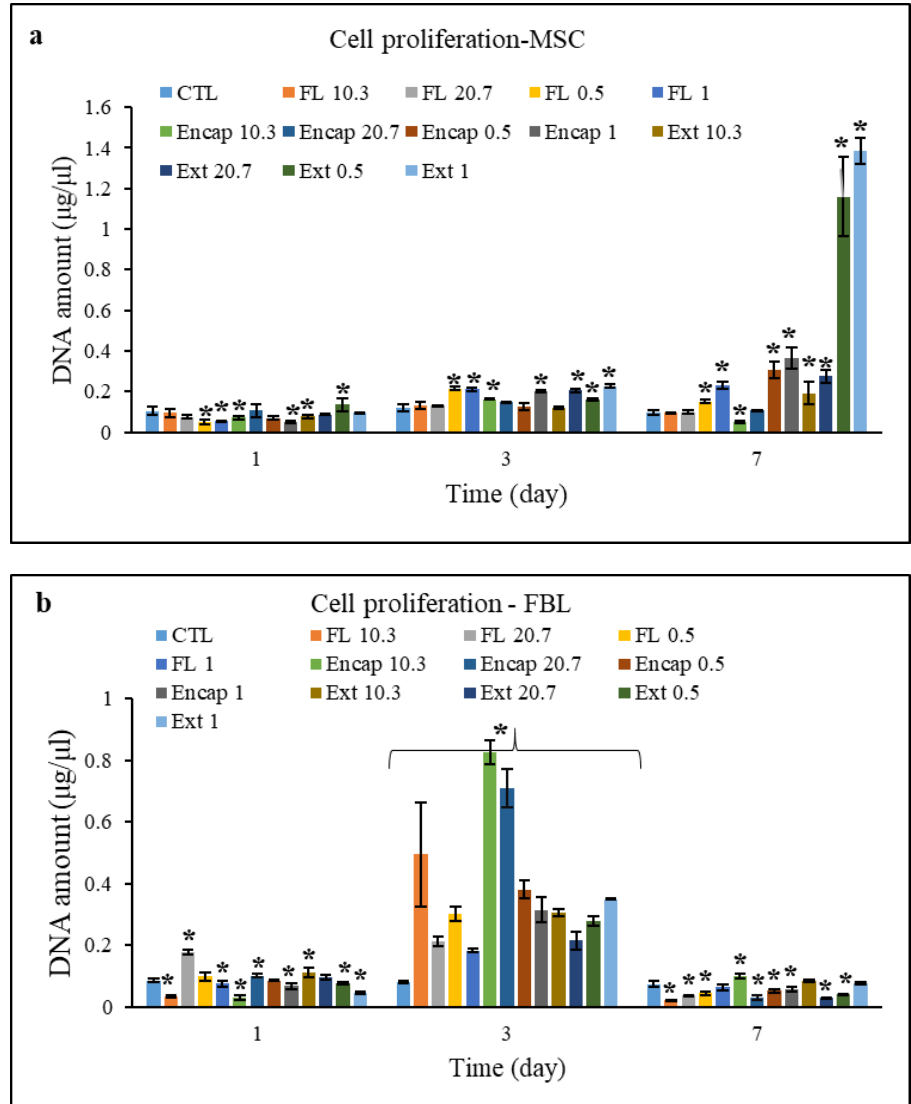
Figure 5. Cell proliferation of human cells: ( a )—MSC cells, ( b )—FBL cells under different treatments by: AC extract (Ext), unloaded nanoliposomes (FL) and AC-loaded nanoliposomes (Encap). CTL is control sample including unstimulated cells. Indexes of 1, 0.5, 20.7 and 10.3 represent the concentration of different treatments as 1 mg.mL −1 , 0.5 mg.mL −1 , 20.7 µg.mL −1 , and 10.4 µg.mL −1 respectively. * indicates there is significant statistical difference between different treatments and control sample ( p < 0.05). The results are mean of three replications ± SD.